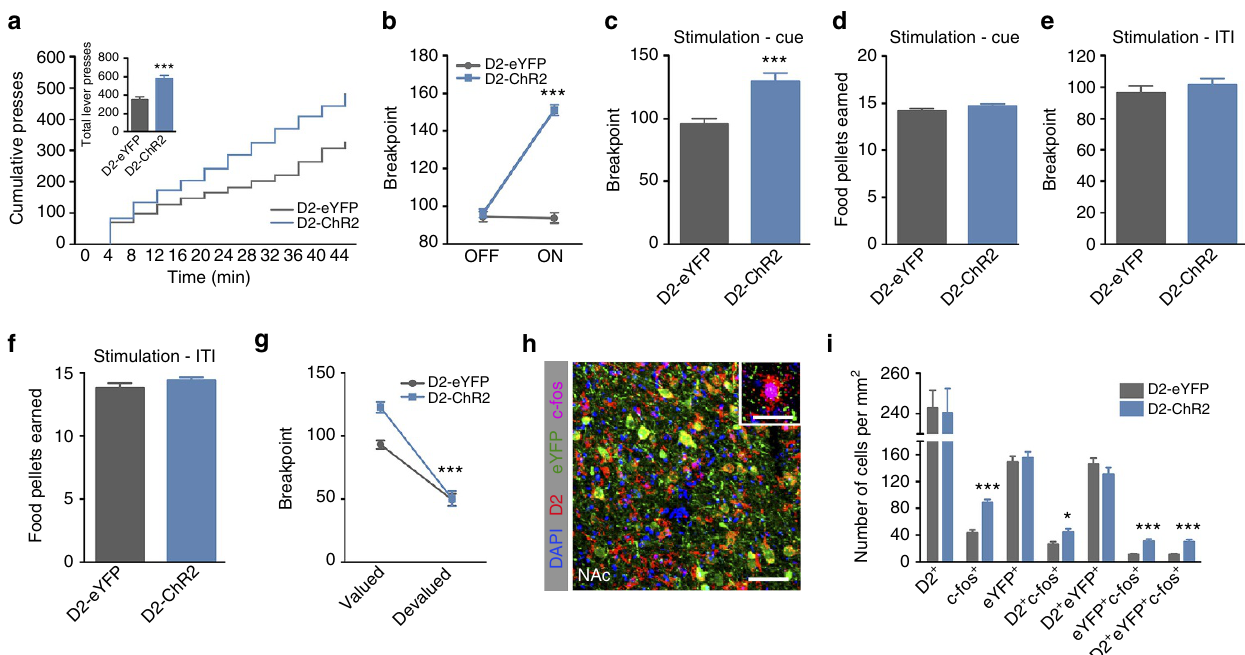
Figure 4 | Optogenetic activation of NAc D2 neurons increases motivation in rats. ( a ) Optogenetic stimulation of D2-ChR2 animals during cue exposure (40Hz, 12.5ms pulses for 1s) increases cumulative presses in the PR test (n D2-ChR2 ¼ 16; n D2-eYFP ¼ 13). ( b , c ) D2 activation during cue exposure induces a significantly higher breakpoint; though animals receive the same number of pellets in the session ( d ). ( e ) D2 activation during inter-trial interval (ITI) does not change breakpoint (n D2-ChR2-eYFP ¼ 7; n D2-eYFP ¼ 5). ( f ) Total number of food pellets earned in the PR session, in which optical stimulation was given during the ITI. ( g ) Outcome devaluation decreases lever presses in both groups. ( h ) Representative immunofluorescence for c-fos þ /D2 þ /eYFP þ in the NAc; scale bar: 200 m m; inset: 40 m m. ( i ) Quantification of c-fos þ /D2 þ /eYFP þ cells in the NAc of stimulated animals showing the recruitment of D2 þ